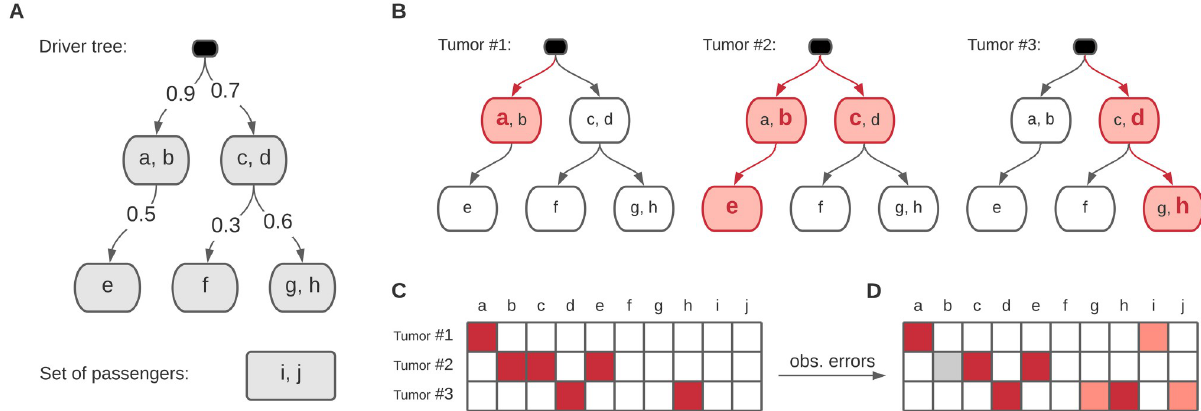
Fig 1. A . An example cancer progression model. B . Three tumors evolved following the model. The firing edges are shown in red. The mutated nodes are filled in red, and the genes with driver mutations are shown in bold red font. C . The binary matrix representation of the driver mutations in the example tumors. The blocks filled in red represent the 1’s. D . The observed dataset including errors in the forms of false positives (light red) and false negatives (gray).